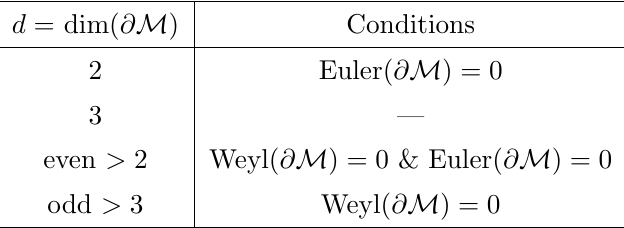
Table 1 . Necessary and su(cid:14)cient conditions for the validity of the boundary Kounterterms. Except in four dimensions ( d = 3), the Kounterterms regulate the AdS variational problem if and only if the Weyl tensor of the boundary is zero (odd d > 3), or both the Weyl tensor and Euler density of the boundary vanish (even d